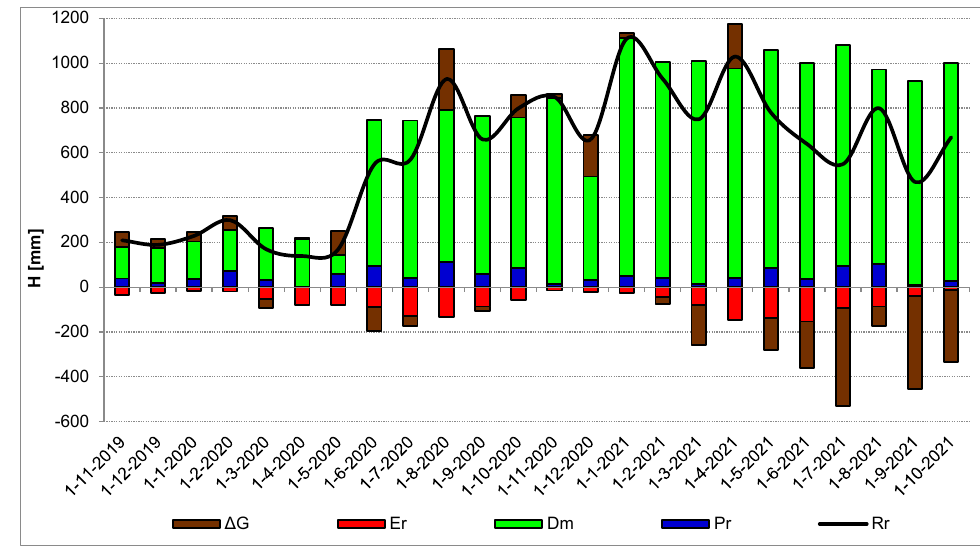
Figure 6. Water balance of the Kleczew reservoir at a monthly scale for the period 2020–2021 ( Δ G— resultant of groundwater inflow and outflow, Er—evaporation from reservoir surface, D m —discharge of mine waters, Pr—precipitation on reservoir surface, Rr—retention of the reservoir). Table 2. Water quality in the Kleczew Reservoir (based on data of Konin Brown Coal Mine—PAK KWB Konin).